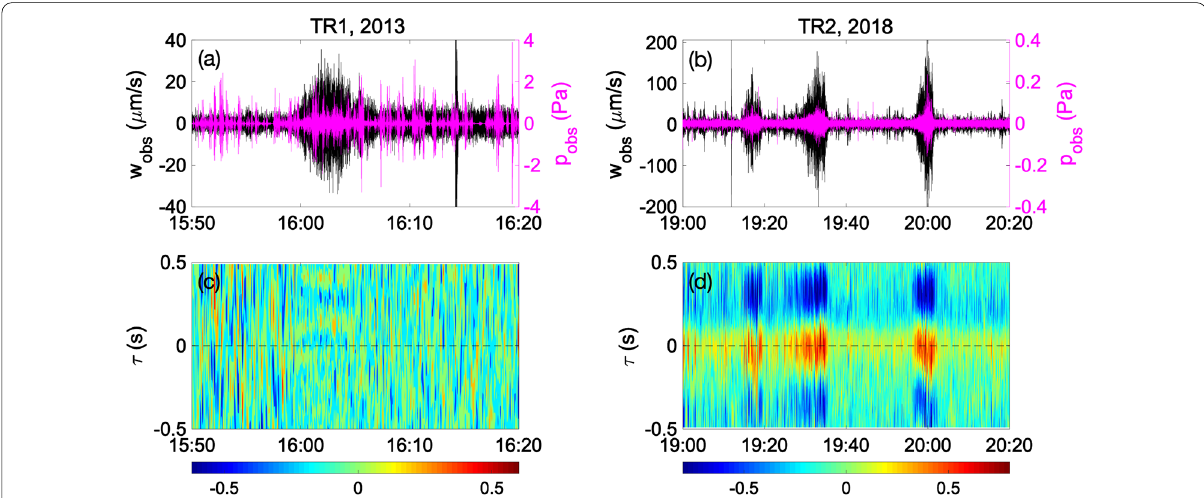
Fig. 4 a , b TR1 and TR2 waveforms recorded at IOCD. The black shows the vertical component of the seismometer, and the magenta shows the microphone record. The data were filtered within the frequency band of 1–10 Hz. c , d The cross-correlation of the seismic and infrasonic data in a , b in a 5-s time window sliding every 1 s. The vertical axis, τ , is the time delay of the seismic to infrasonic data